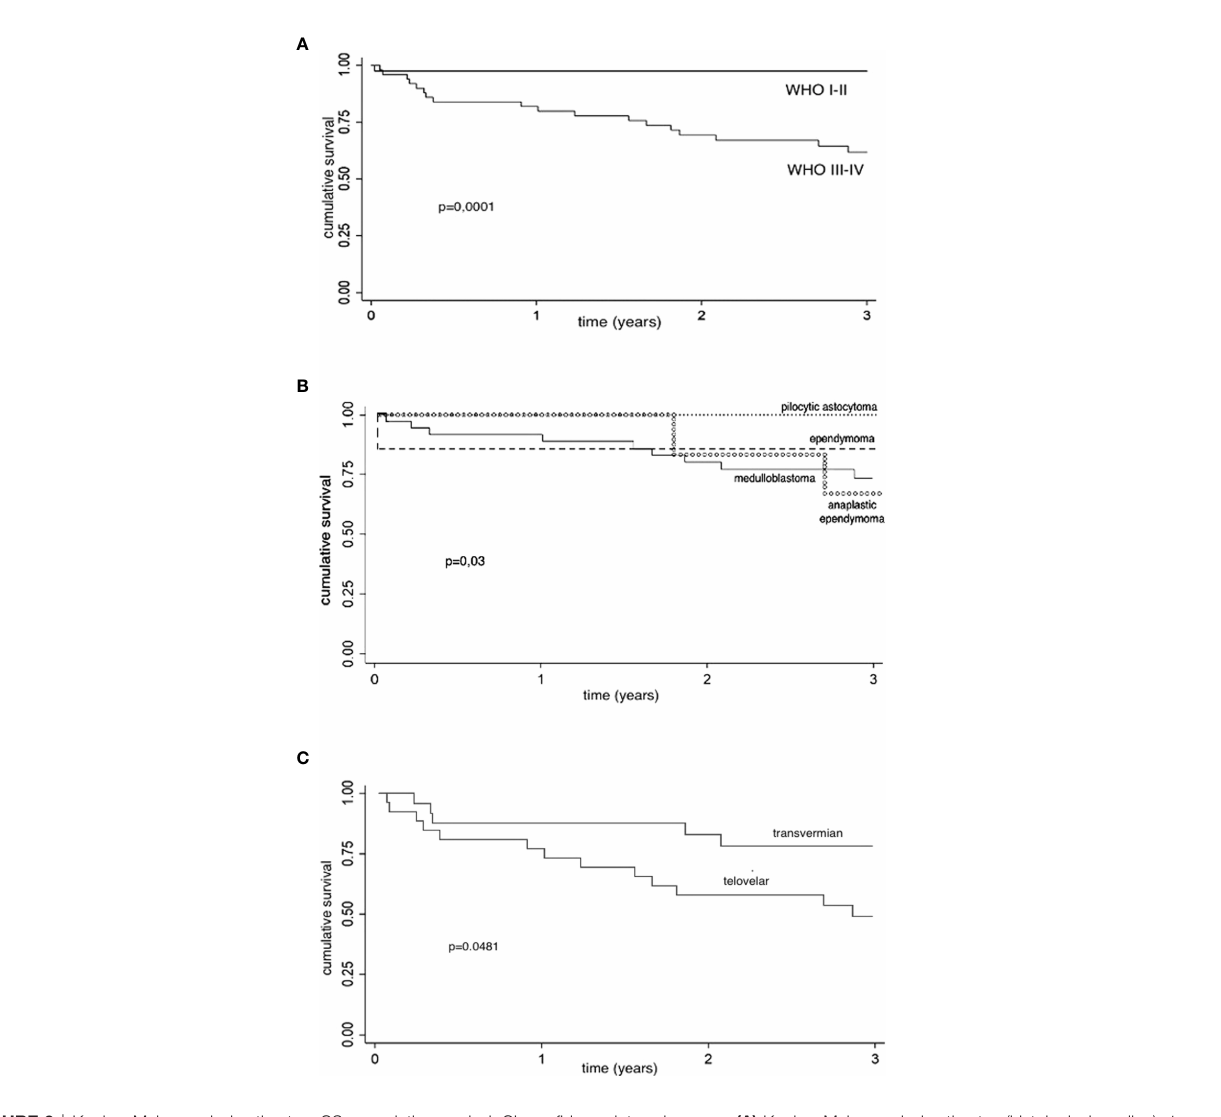
FIGURE 2 | Kaplan – Meier survival estimates. CS, cumulative survival; CI, con fi dence interval; y, year. (A) Kaplan – Meier survival estimates (histological grading): 1- and 3-year CS are analyzed in relation to histological grading (WHO 1 – 2 vs. WHO 3 – 4), showing a better 1- and 3-year CS for low-grade group (log-rank test, p = 0.0001). Low-grade tumors: 1-year CS, 97.6% (95% CI: 83.9% – 99.7%); 3-year CS, 97.6% (95% CI: 83.9% – 99.7%). High-grade tumors: 1-year CS, 82% (95% CI: 68.2% – 90.2%); 3-year CS: 62% (95% CI: 46.4% – 74.2%). (B) Kaplan-Meier survival estimates (histology): 1- and 3-year CS are analyzed in relation to histology (log- rank test, p = 0.03). Pilocytic astrocytoma: 1- and 3-year CS, 100%. Non-anaplastic ependymomas: 1-y CS, 85.7% (95% CI: 33.4% – 97.9%); 3-year CS, 85.7% (95% CI, 33.4% – 97.9%). Medulloblastomas: 1-year CS, 91.9% (95% CI, 76.9% – 97.3%); 3-year CS, 73.6% (95% CI: 55.1% – 85.4%). Anaplastic ependymomas: 1- year CS, 100%; 3-year CS, 66.7% (95% CI: 19.5% – 90.4%). (C) Kaplan – Meier survival estimates (surgical approach for high-grade tumors): Considering the choice of surgical approach for high-grade tumors (WHO 3 – 4), we found better 1- and 3-years CS of transvermian approach when compared to telovelar approach with statistical signi fi cance (log-rank test, p = 0.048). Telovelar approach: 1-year CS, 76.9% (95% CI: 55.7% – 88,9%); 3-year CS, 48.8% (95% CI, 28.5% – 66.4%). Transvermian approach: 1-year CS, 87.5% (95% CI: 66.1% – 95.8%); 3-year CS, 78% (95% CI, 54.8% – 90.3%). The power of predicting factors (surgical approach for high-grade tumors and residual tumor volume) is evaluated in a Cox proportional hazard model ( Table 4